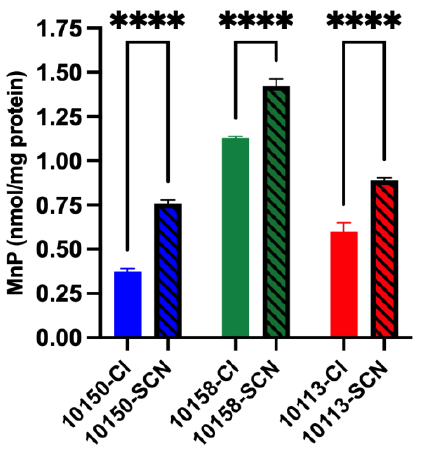
Figure 7. Cellular uptake of manganese porphyrin (MnP) formulations . Human bronchial epithe- lial cells (16HBE41o-) were treated for 24 h with either the MnP(Cl) or MnP(SCN) formulation and intracellular MnP concentrations were determined by HPLC. MnP(SCN) formulations had higher intracellular levels than did MnP(Cl) formulations; **** p < 0.001.